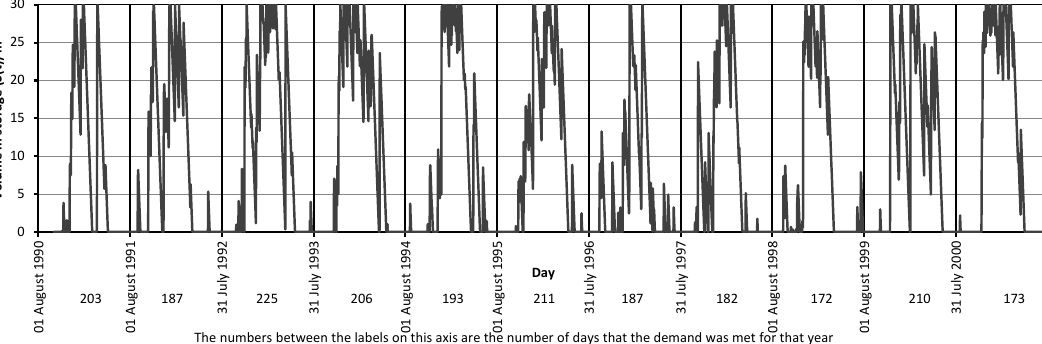
Fig. 2 School RWH storage behaviour and number of days supplied for an 11-year long period. Table 1 Number of students attending the schools (obtained from South African Schools.net 2010) and the vertically projected roof areas ( A ) obtained from Google-Earth Name No. S Area No. (m 2 )